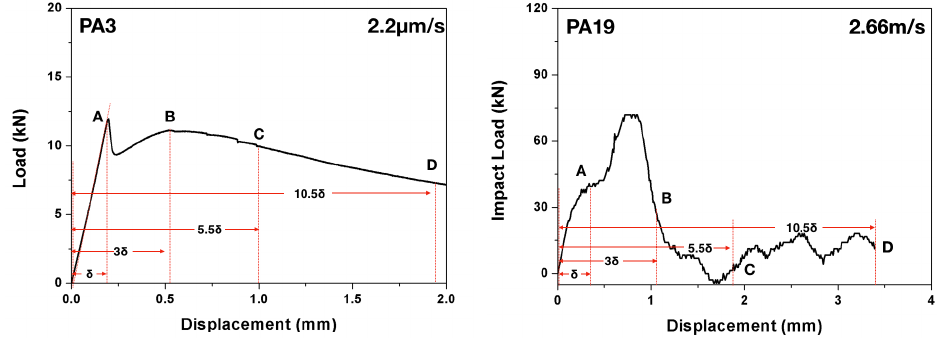
Figure 4. Measuring the toughness indices using the load-deflection curve (shown for PA3 loaded at 2.2 µ /s and PA19 impacted at 2.66